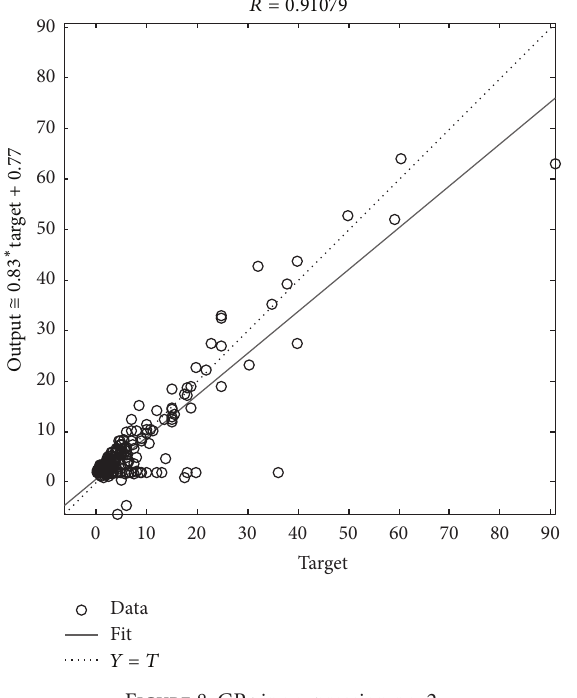
Figure 9: GP zinc expression no. 3. Table 2: The zinc dataset used in the experiments (adapted from [10,